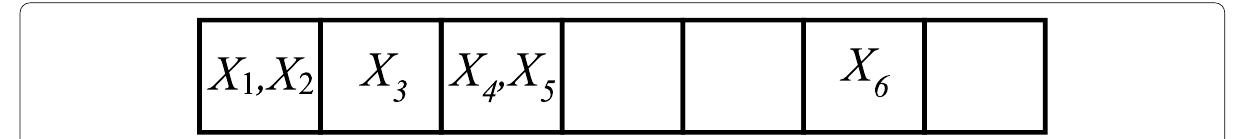
Fig. 3 Locality sensitive hashing